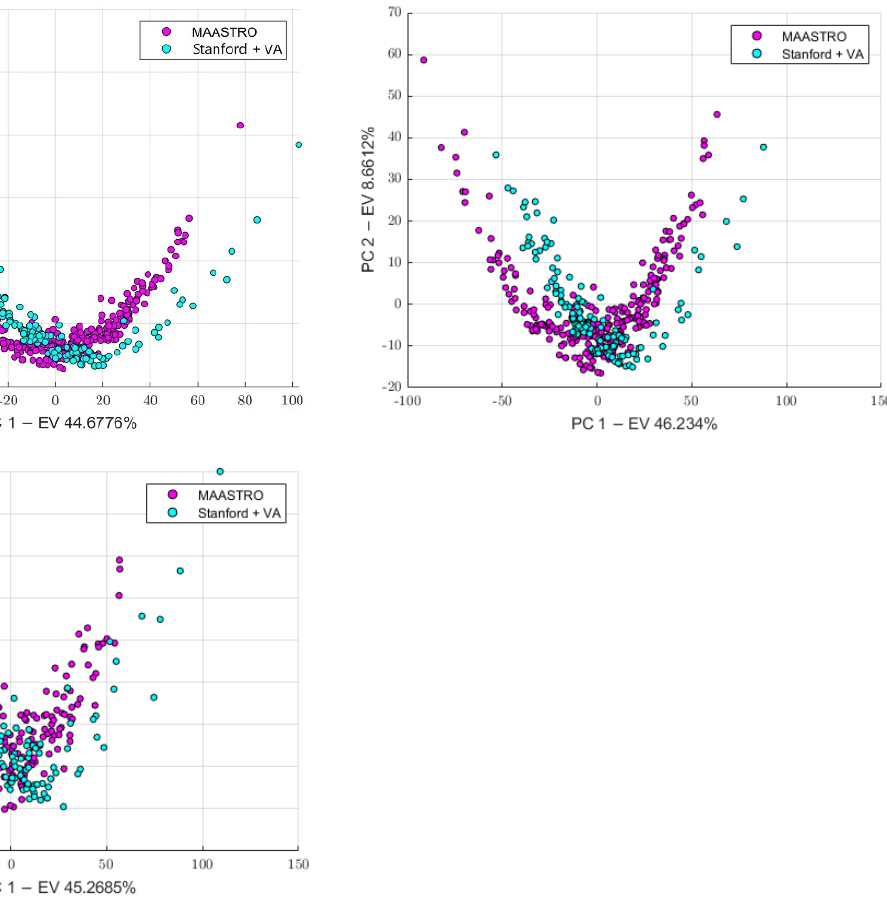
Figure 9. The PCA scatter plot after harmonization. The 4-classes are on the top-left , the 3-classes are on the top-right , the 2-classes are on the bottom-left .